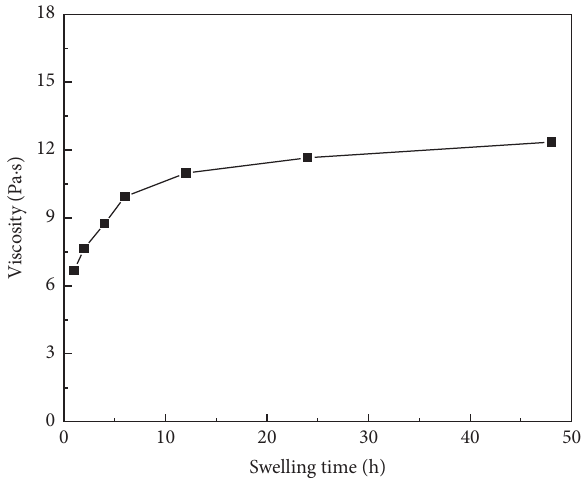
Figure 5: Influence of swelling time on the viscosity of SBS